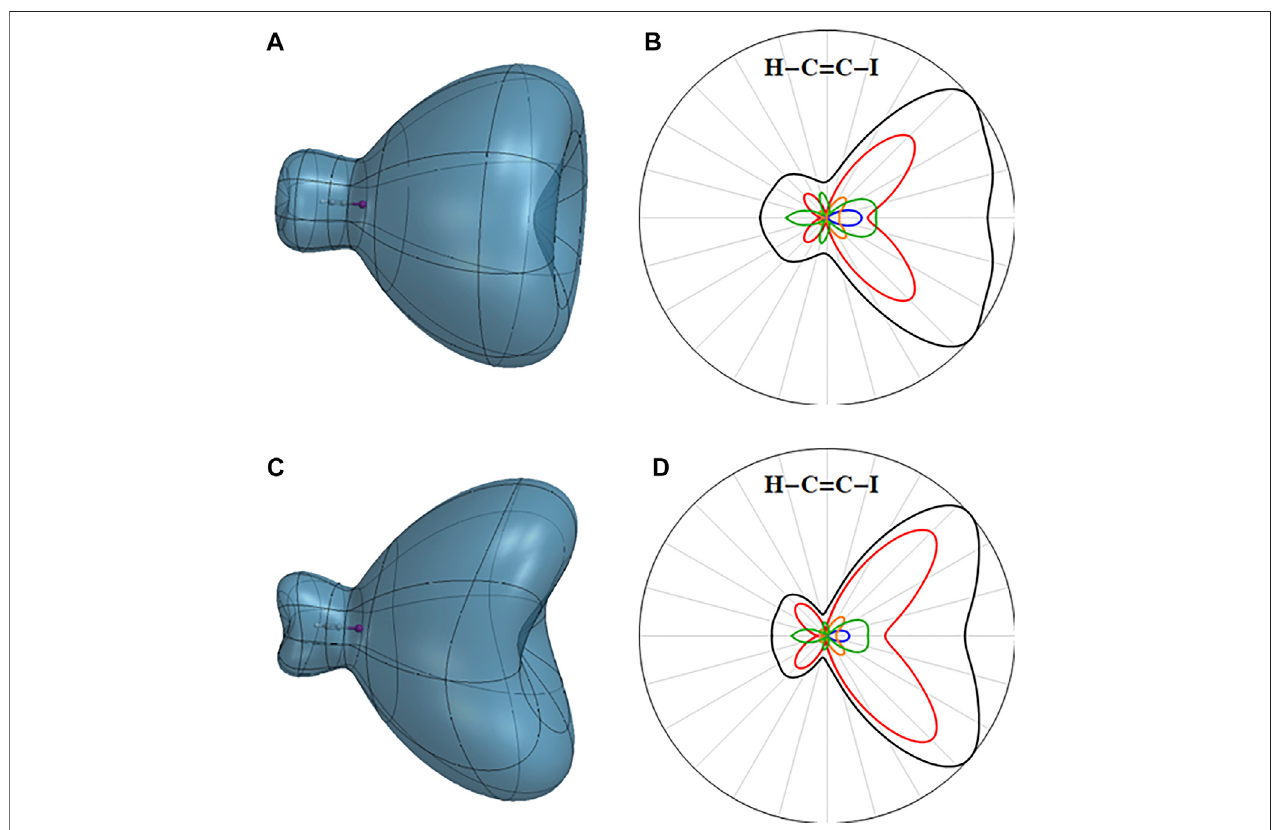
FIGURE 4 | Three-dimensional angular dependence of the instantaneous ionization rate for the fi rst excited state of the HCCI cation in a static fi eld of 0.055 au for (A) theA( (cid:2) π − 1 + )cationand (C) theA( (cid:2) π − 1 x )cation.Totalionizationratesinblackand contributions fromionizingthe π p and (cid:2) π p orbitalsinred( i.e. yieldingthe( (cid:2) π − 1 , π p − 1 )and ( (cid:2) π − 1 , (cid:2) π p − 1 )doublyionizedcon fi gurations),contributionsyieldingthe( π p − 1 , (cid:2) π − 1 y ),( (cid:2) π p − 1 , (cid:2) π − 1 y ),( π − 1 , (cid:2) π p − 1 y ),and( (cid:2) π − 1 , (cid:2) π p − 1 y )doublyionizedcon fi gurationsinblue,the( π − 1 , (cid:2) π p − 1 fi gurations in orange and the ( π p − 1 , π p − 1 ), ( π p − 1 , (cid:2) π p − 1 ), and ( (cid:2) π p − 1 , (cid:2) π p − 1 ) con fi gurations in green for (B) the A ( (cid:2) π − 1 x ) con